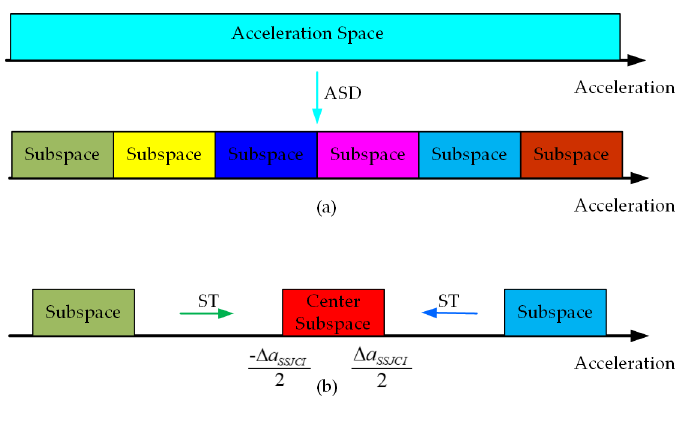
Figure 3. The diagrams of ASD and ST operations: ( a ) the diagram of ASD operation; ( b ) the diagram of ST